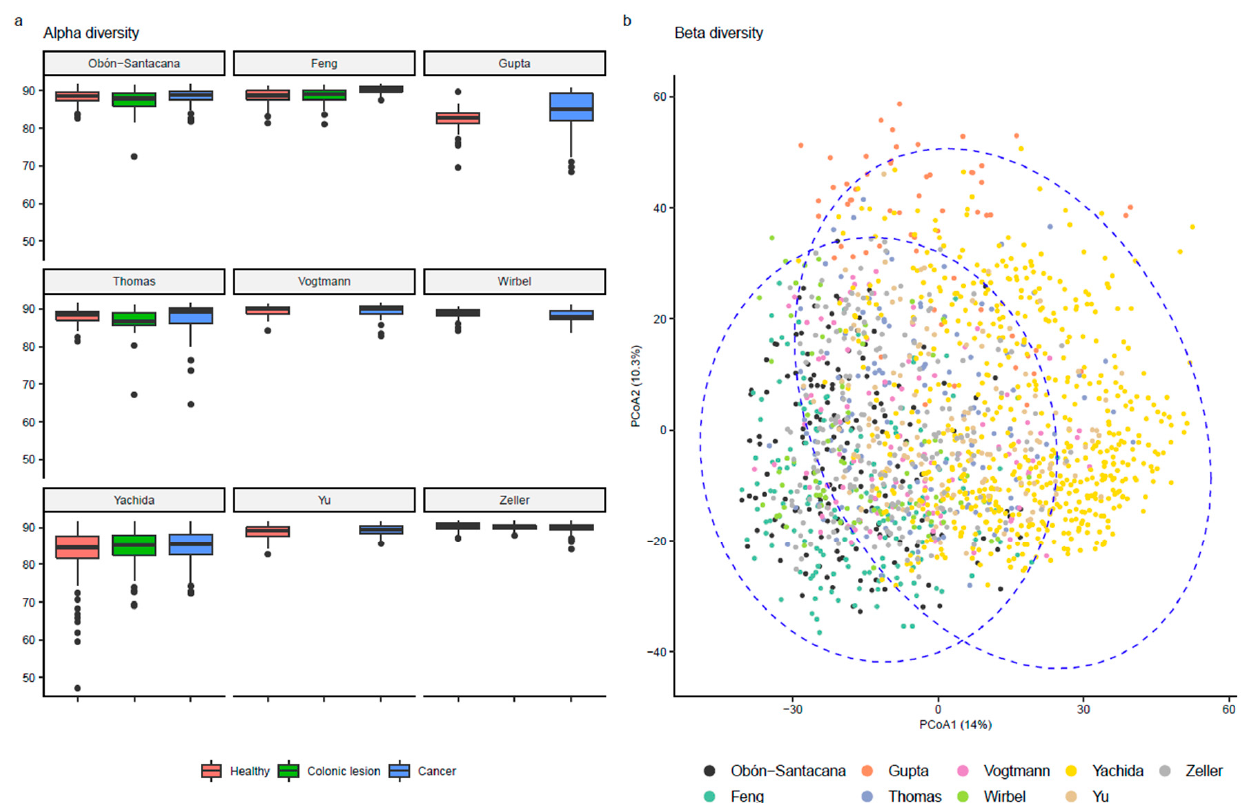
Figure 1. Microbiome diversity statistics of the included metagenomic datasets. ( a ) Alpha diversity metrics (Faith’s index). ( b ) Beta diversity metrics (based on Euclidean distances of ILR-transformed relative abundance counts). The right ellipse represents Asian studies (Gupta, Yachida and Yu) meanwhile the left ellipse depicts USA and EU studies (Feng, Ob ó n-Santacana, Thomas, Vogtmann, Wirbel and Zeller). Both ellipses represent a 95% confidence